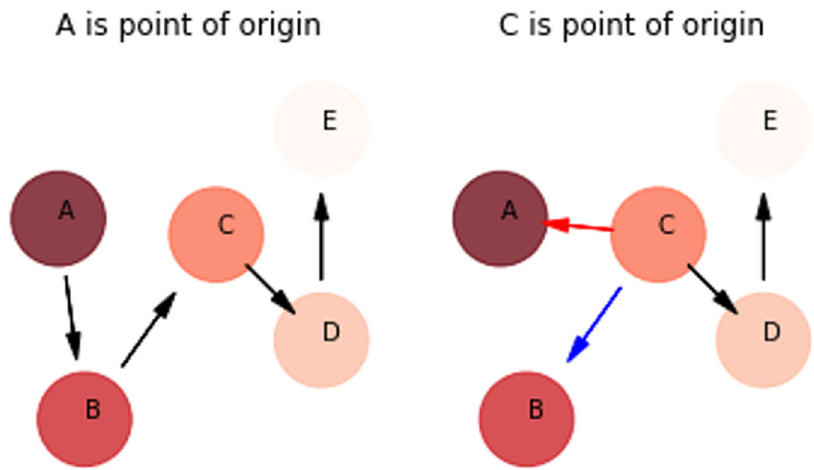
Fig. 3 Potential migratory routes consistent with the phylogenetic tree in Fig. 2. A single migratory process starting at A is depicted on the left, while three different processes starting from C are shown on